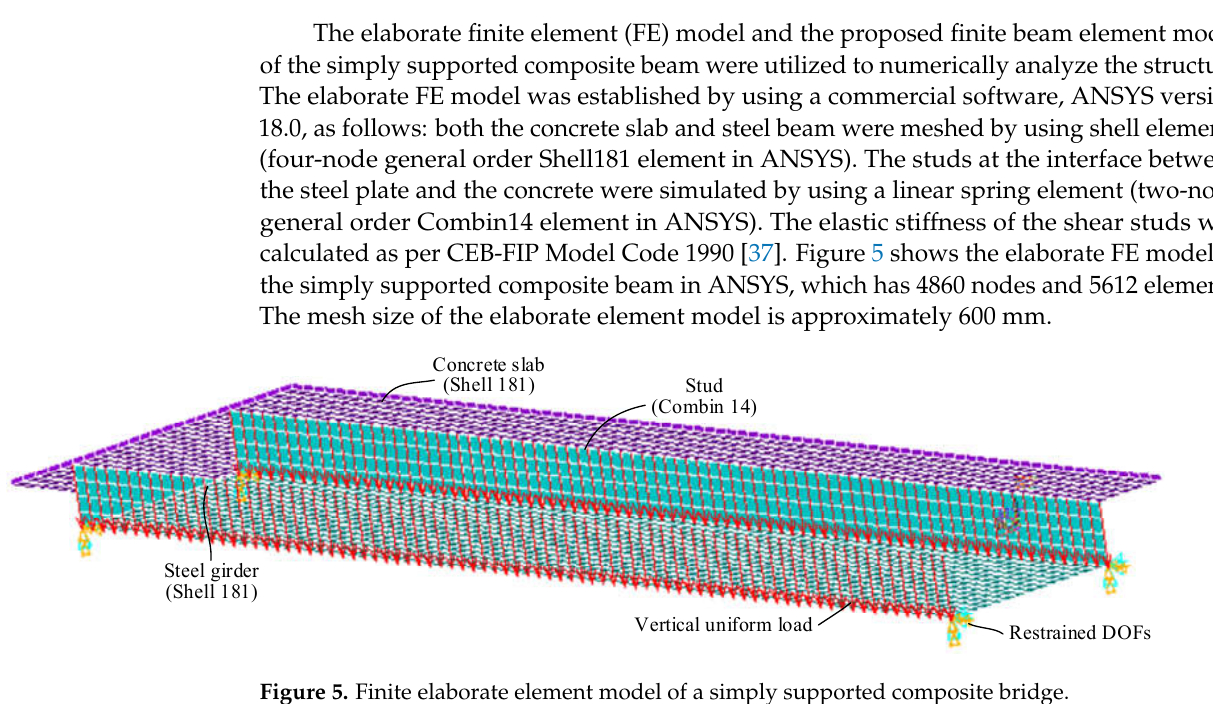
Table 2. Boundary conditions for beam element model.